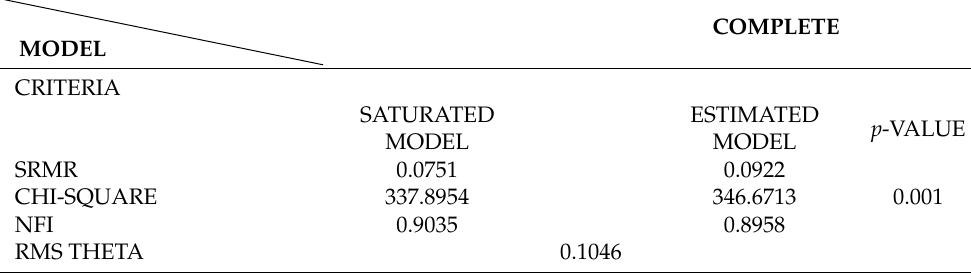
Table 9. Model Fit Summary.